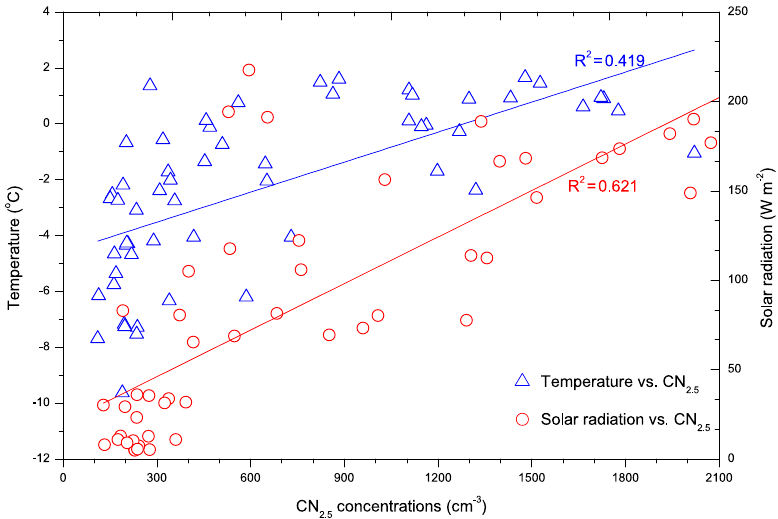
Figure 5. Scatterplot diagram of monthly mean CN 2 . 5 concentrations and monthly mean temperature (blue open triangle) or monthly mean solar radiation intensity (red open circle). Blue and red solid lines are regression